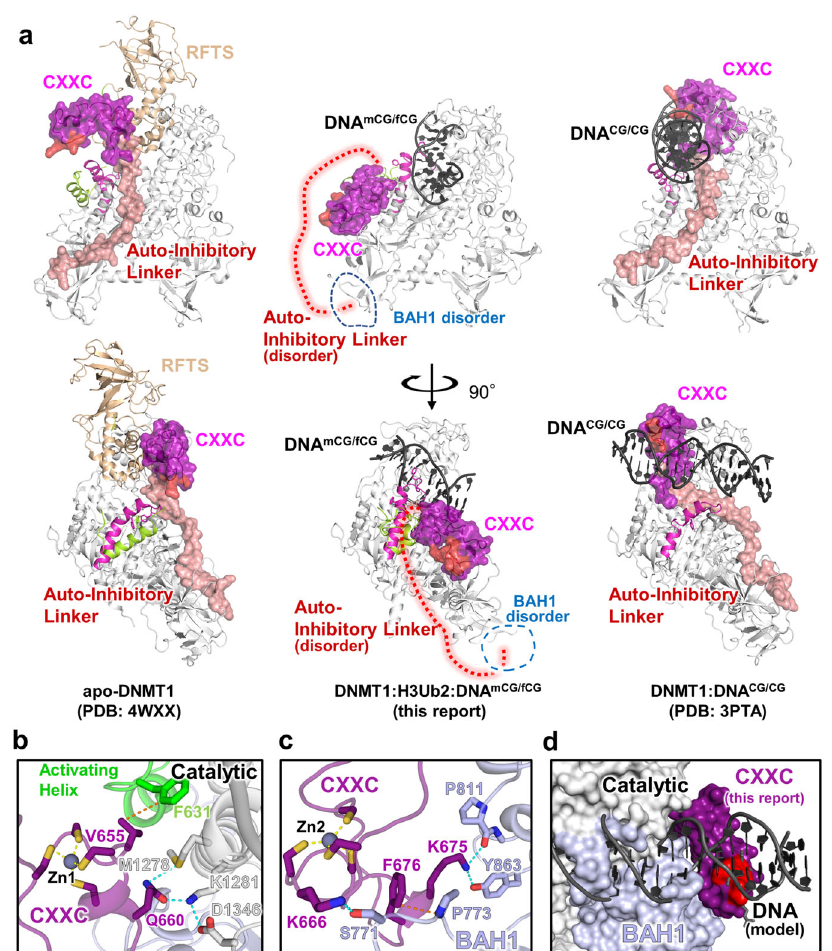
Fig. 2 | Spatial rearrangement of the CXXC domain upon activation. a Comparison of the overall structure of apo-DNMT1 (left, PDB:4WXX), DNMT1: H3Ub2:DNA mCG/fCG ternarycomplex(center,thisstudy),andDNMT1:DNA CG/CG binary complex (right, PDB:3PTA).Upperand lower panelsshow the side and front views of DNMT1, respectively. RFTS domain, Activating Helix, CXXC domain, Auto- Inhibitory Linker, and DNA Recognition Helix were colored light orange, light green,purple,red,andpink,respectively.CXXCdomainandAuto-InhibitoryLinker are also exhibited as the transparent surface model. The disordered regions of BAH1 and Auto-Inhibitory Linker in DNMT1:H3Ub2:DNA mCG/fCG ternary complex are